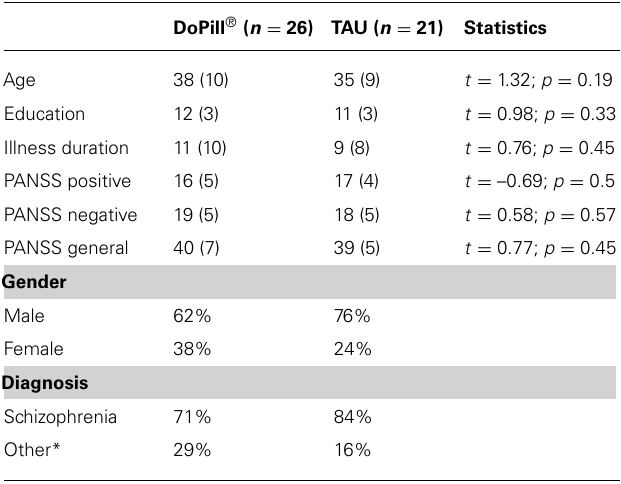
Table 1 | Baseline sociodemographic and clinical characteristics of randomized